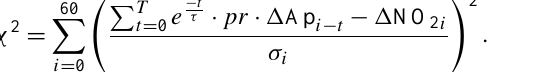
Fig. 3. Correlation coefficient r of the SEA with respect to ∆ Ap (epoch type 2) between ∆ Ap and ∆NO 2 , plotted over geomag- netic latitudes with 0/1/2 days delay (top/middle/bottom, respec- tively).